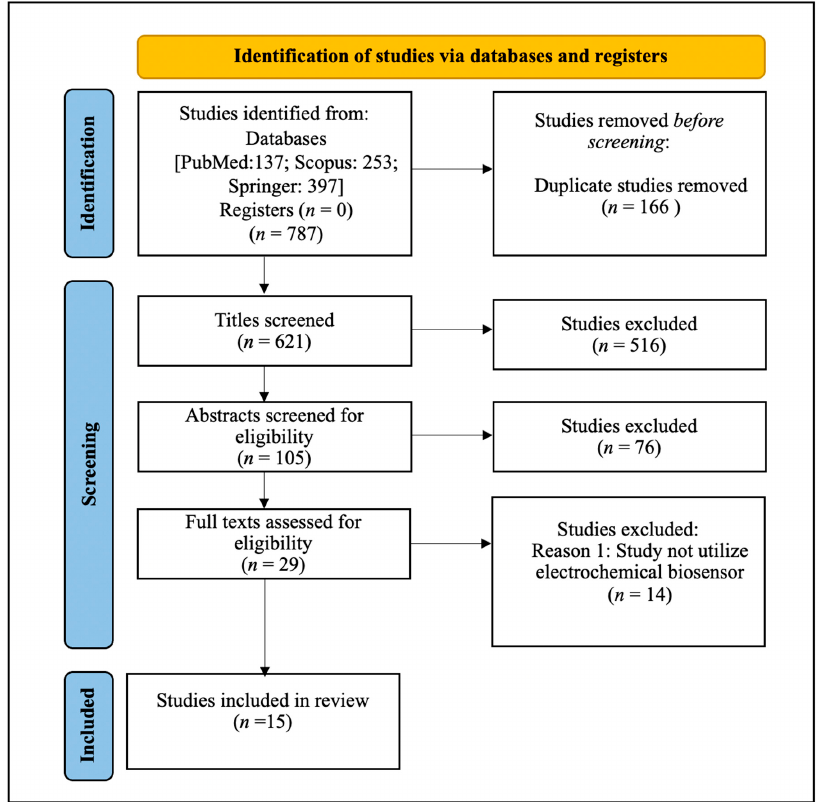
Figure 1. PRISMA-ScR flowchart of the scoping review process.